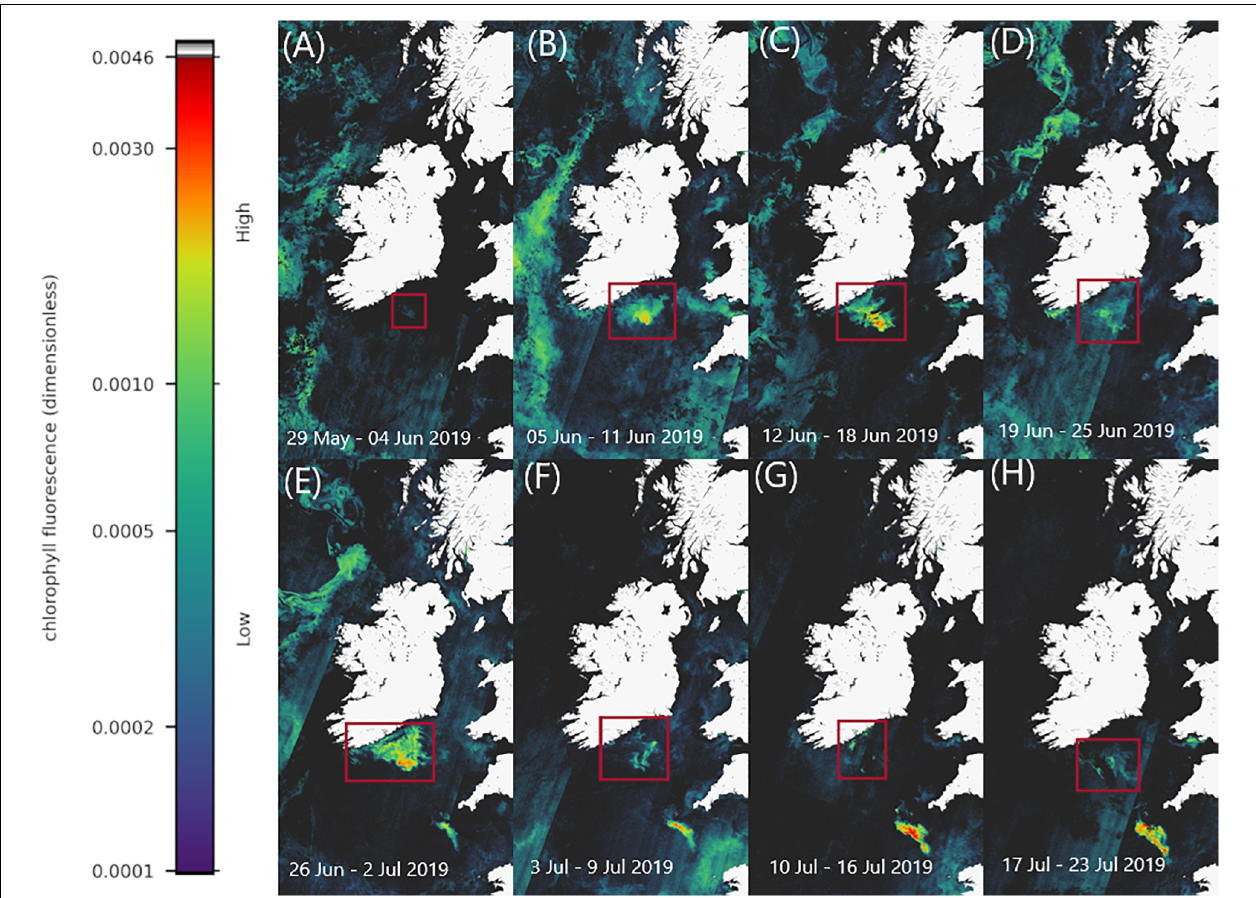
FIGURE 2 | Sentinel-3a OLCI images with RBD algorithm displaying the phytoplankton bloom progression between 29th May 2019 and 23rd July 2019 (A–H) . Colours indicate relative fluorescence, with warmer colours representing higher fluorescence indicative of higher bloom